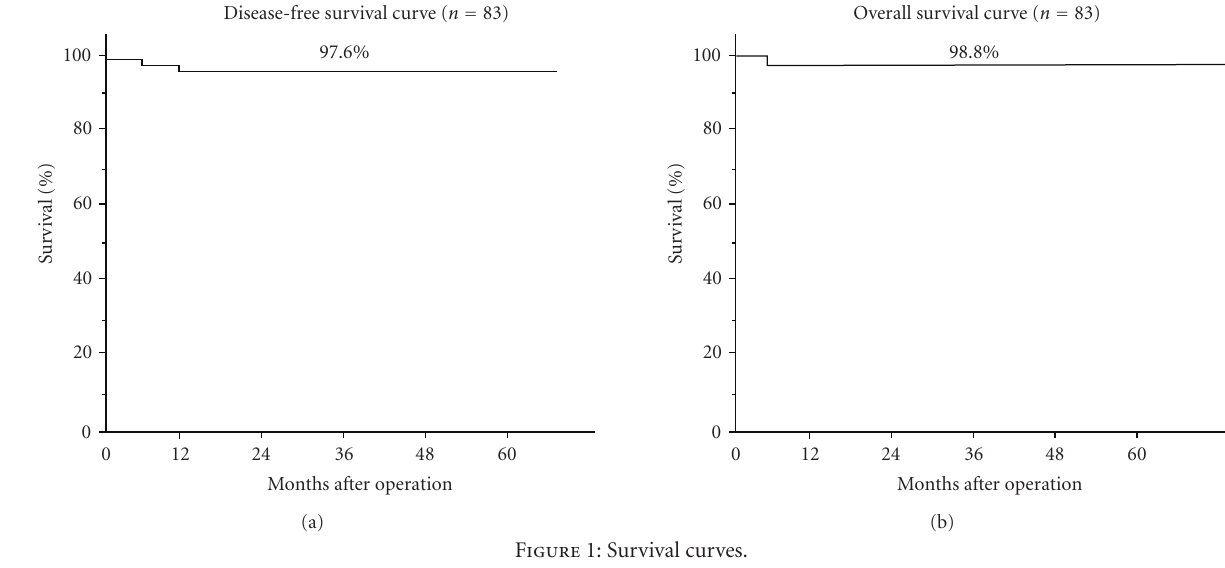
Figure 1: Survival curves.